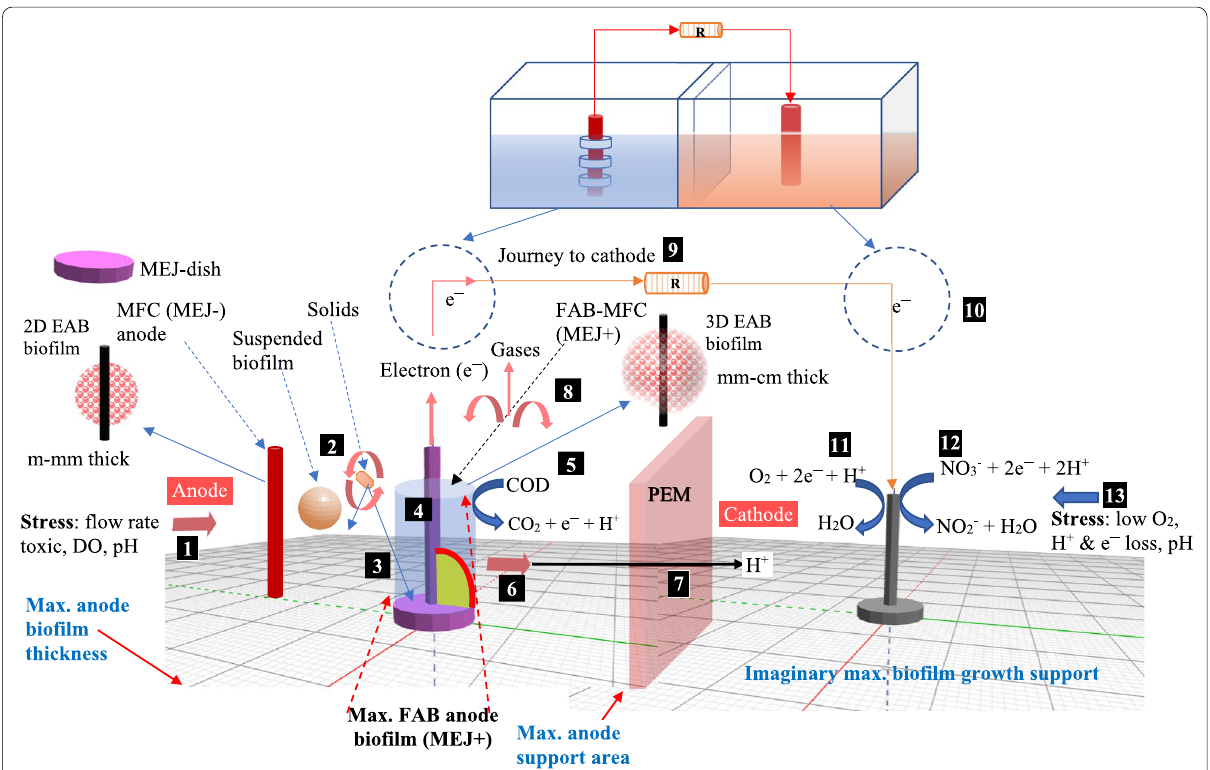
Fig. 9 The proposed conceptual scheme of anode biofilm growth on support media (MEJ-dish) against the hypothetical maximum (max.) surface area and biofilm thickness. The anode biofilm thickness was proposed without assuming extended growth. The numbers in a box (1–13) indicate the MFC substrate and electron flow (Additional file 1: Fig. S1). The MEJ-dish supports to form thick (FAB) anode biofilm (No.